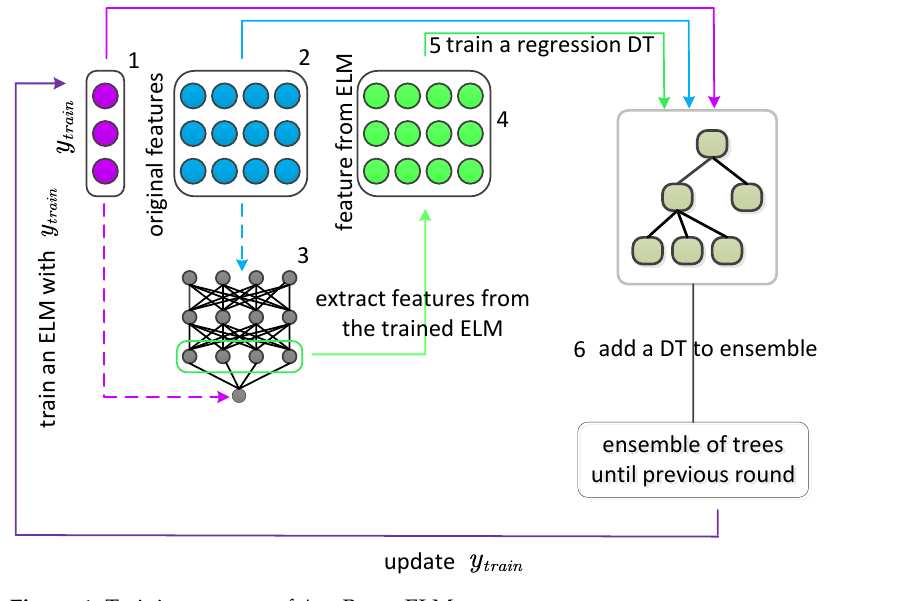
Figure 1. Training process of AugBoost-ELM. Algorithm 1 Pseudo code of